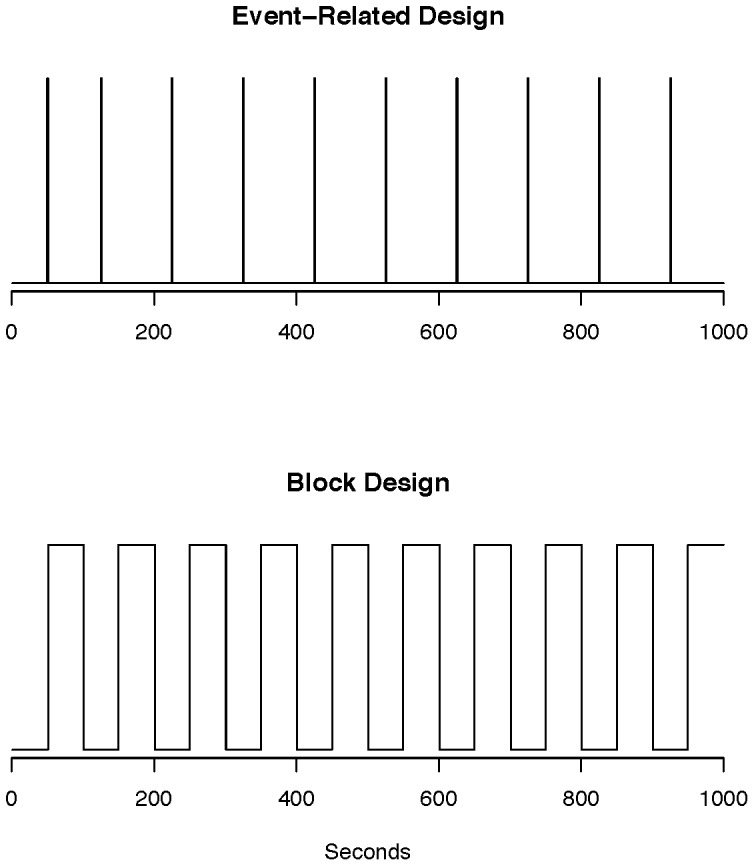
Stimulus vectors for an event-related design (top) and a block design (bottom).The spikes correspond to the onsets of stimuli. There is a sustained period of activity/task in the block design. In both cases, the spacings between events can be unequal.